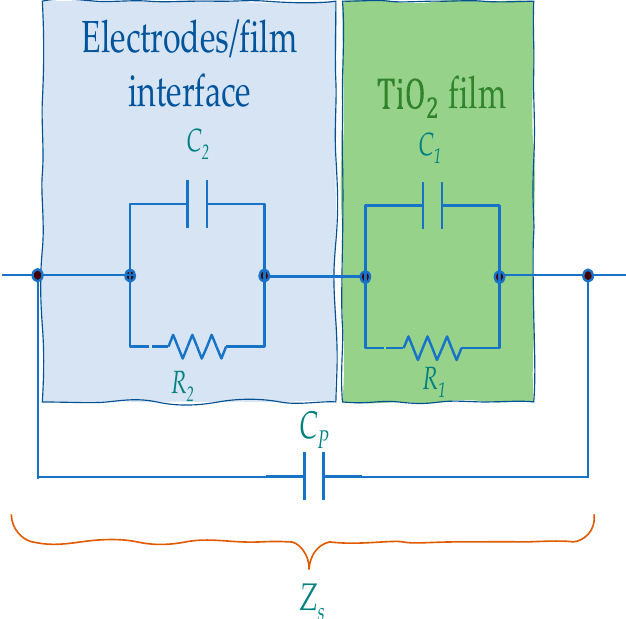
Figure 4. Equivalent electrical circuit of the sensing device.